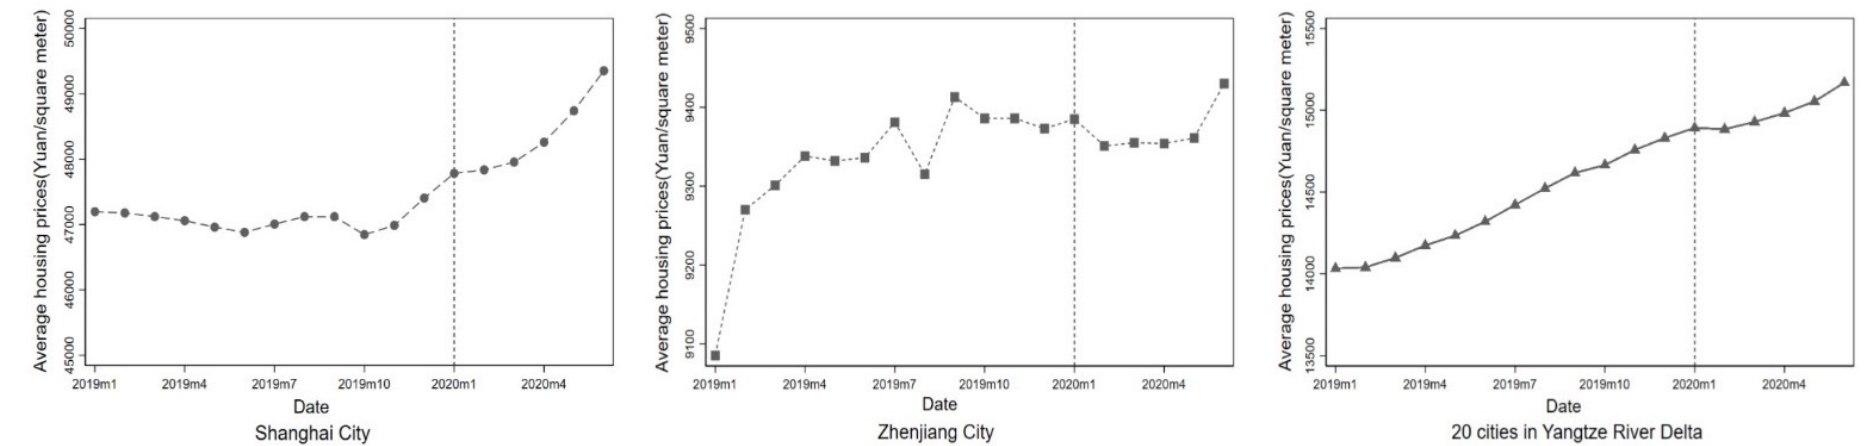
Figure 2. The trends of average housing prices in the Yangtze River Delta, Shanghai and Zhenjiang.